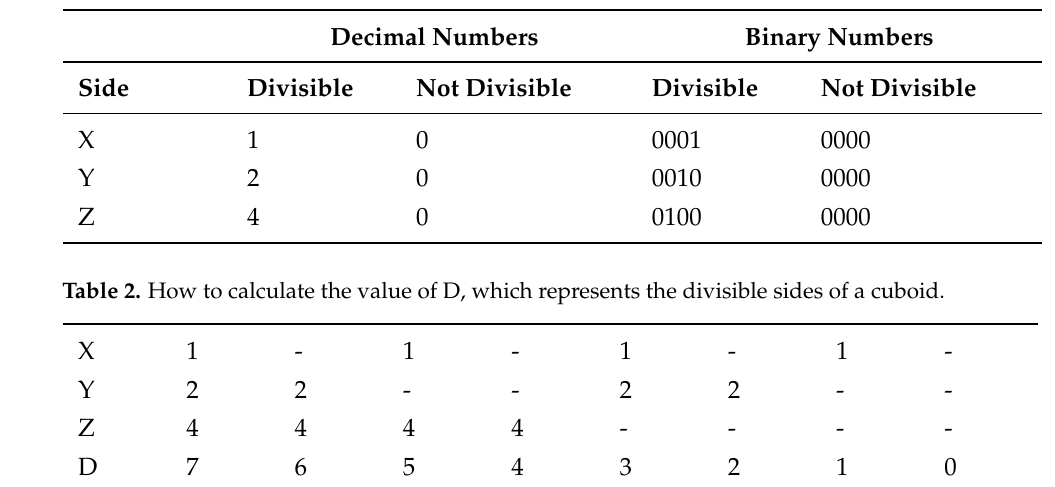
Table 1. Values of divisible sides.